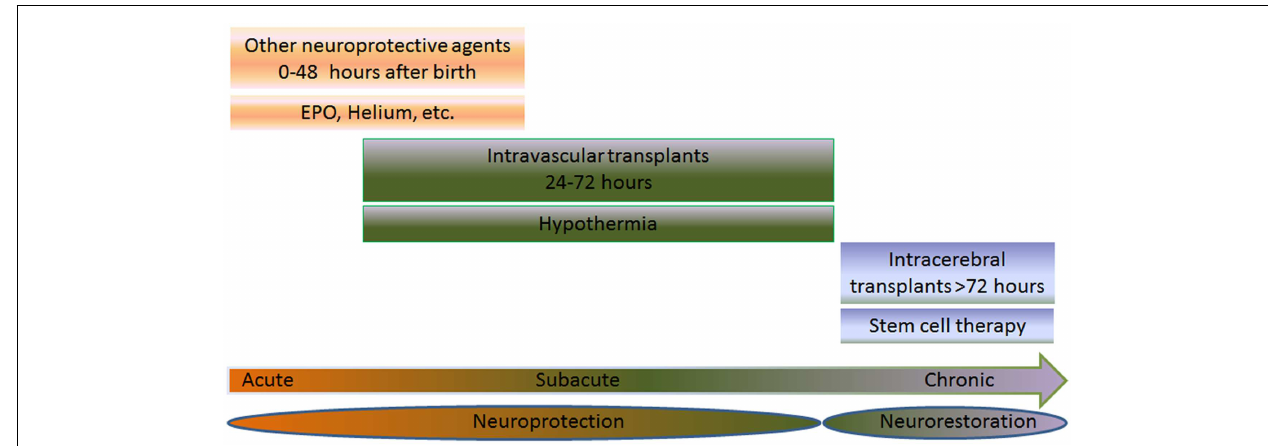
treatments aimed at the chronic stage are referred to as neurorestoration. EPO or helium is used to treat the subject during the acute phase, while hypothermia and stem cell therapy is used to treat the subacute stage via intravascular routes.When treating the chronic stage, stem cell therapy is used via intracerebral route, which stimulates the neurorestorative mechanisms.The combination of these therapies may prove to be effective in neonates suffering from